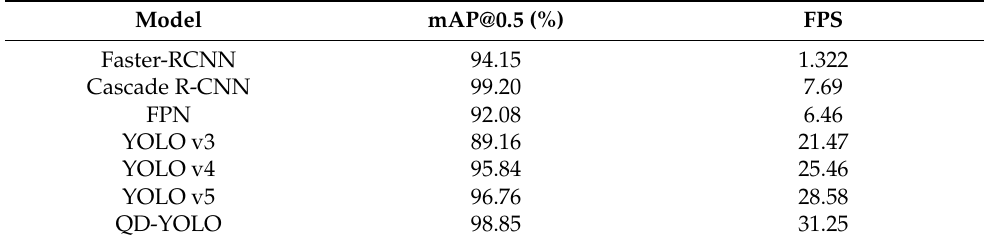
Table 5. Comparison of results of different target detection